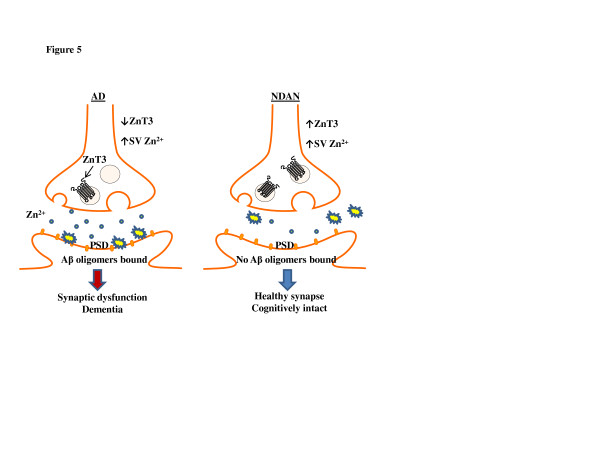
Aβ and Zn2+differences in AD and NDAN hippocampal synapses. A schematic summarizing the findings presented in this report. In AD there is increased Zn2+ in the soluble fraction compared to control and NDAN. However, both AD and NDAN have increased levels of Zn2+ in the synaptic vesicles (SV) which may actually reflect a storage compensatory mechanism to high Zn2+ levels. The reduction of ZnT3 in AD may reflect a dysfunction of this compensatory mechanism, allowing for total Zn2+ levels to increase. Zn2+ is necessary for stabilization and targeting of Aβ oligomers to the PSD. Aβ oligomers are highly associated with the PSD in AD hippocampal synapses, but are absent at NDAN synapses. This key difference could likely be due to the levels and regulation of synaptic Zn2+, resulting in synaptic dysfunction and cognitive decline in AD and preserved synapses and cognition in NDAN cases